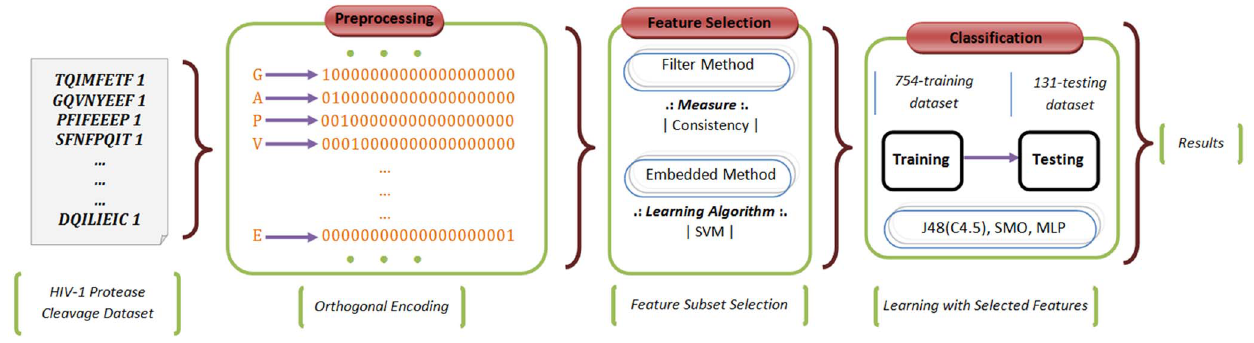
Figure 2. Detailed System Overview. Closer look at the various components of the proposed system architecture; orthonormal encoding is used to represent amino acids.